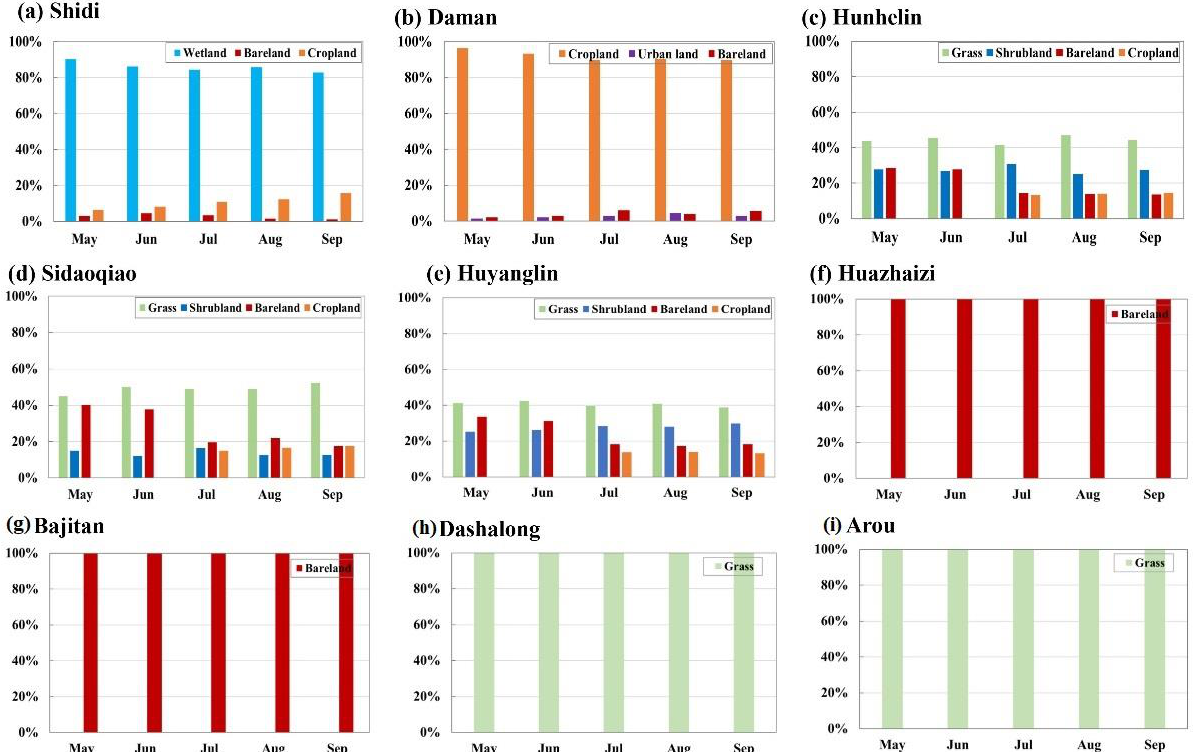
Figure 7. Area ratio of land cover types in the